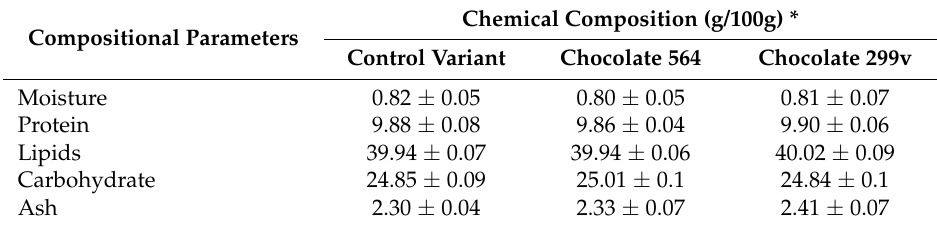
Table 2. Chemical composition of dark chocolates made with and without probiotic bacteria.